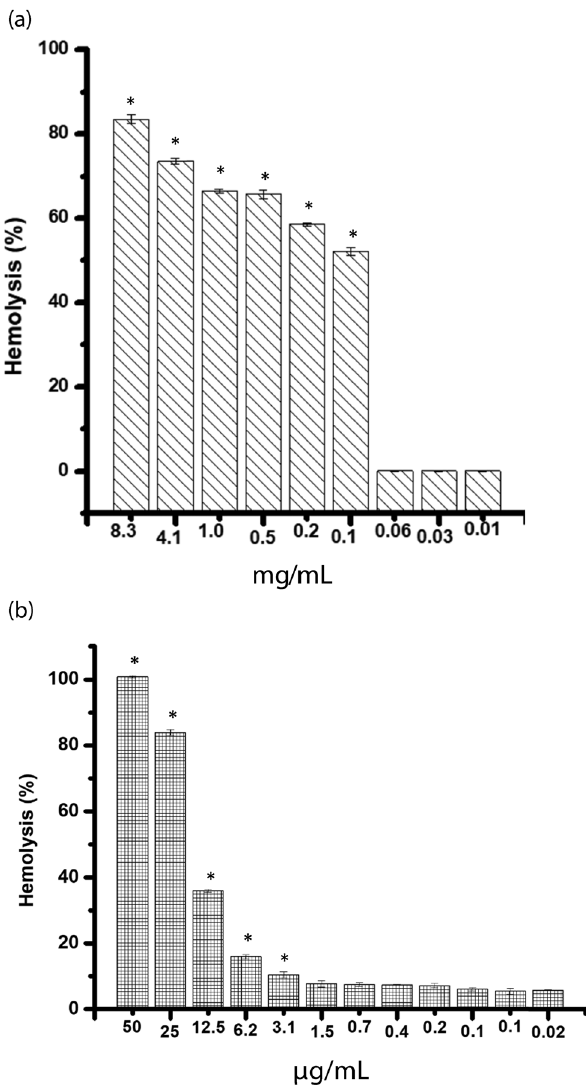
Figure 4: The hemolytic e ff ect of the MFC extract on ( a ) human ( HC 50 : 220 µg/mL ) and ( b ) mouse blood cells ( HC 50 : 16.11 µg/mL ) after 1 h of incubation. Result were considered signi fi cant at ( * ) p <